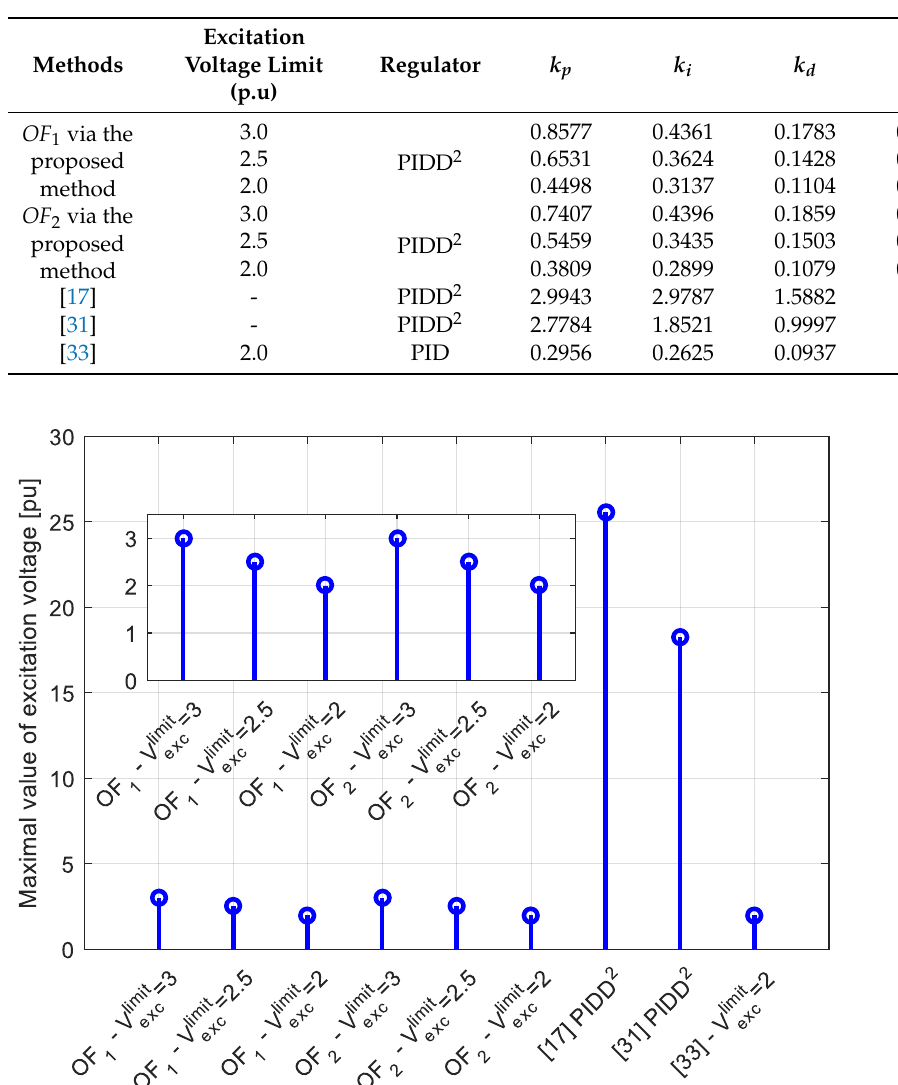
Figure 10. Comparison of the results in terms of the maximum value of the excitation voltage obtained using different methods.